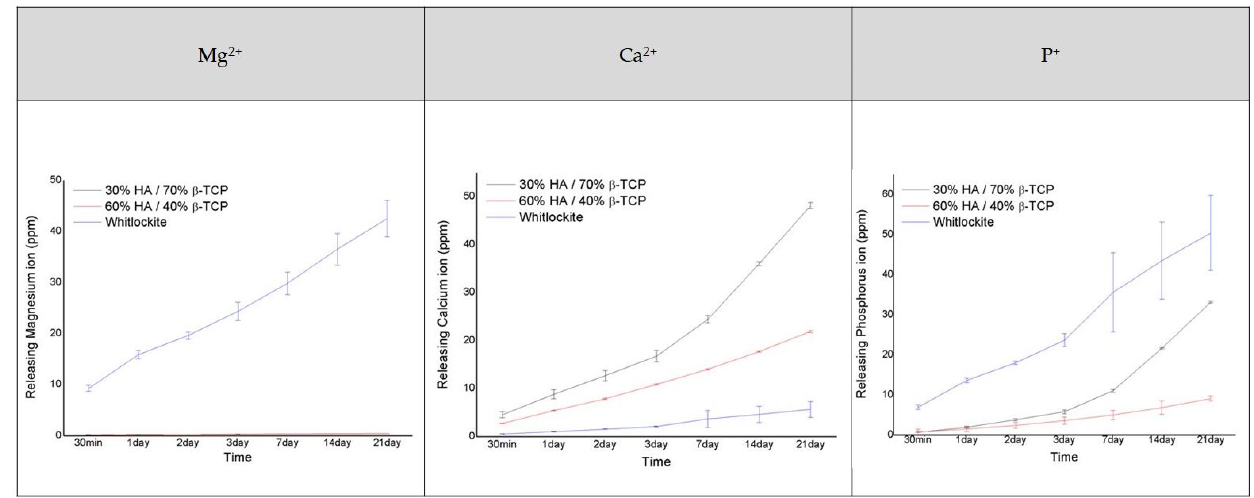
Figure 5. Analysis of the amount of Mg 2+ , Ca 2+ , and P + ions released (as ions related to osteogenic differentiation).